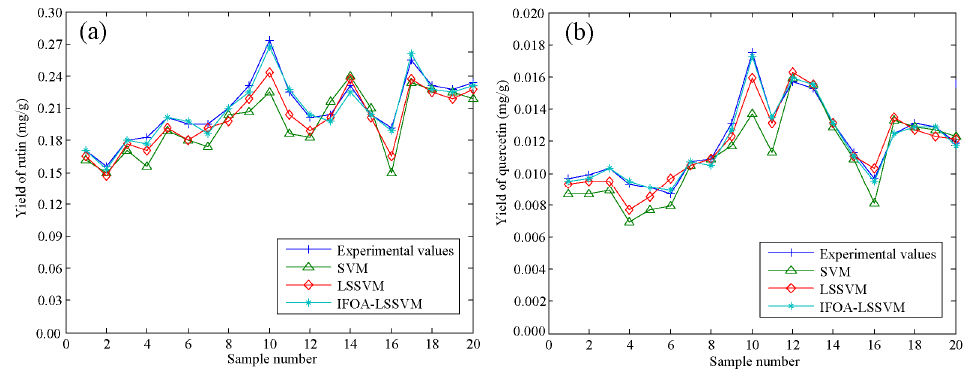
Figure 12. Prediction performance of different models on the generalization dataset of: rutin ( a ); and quercetin ( b ).